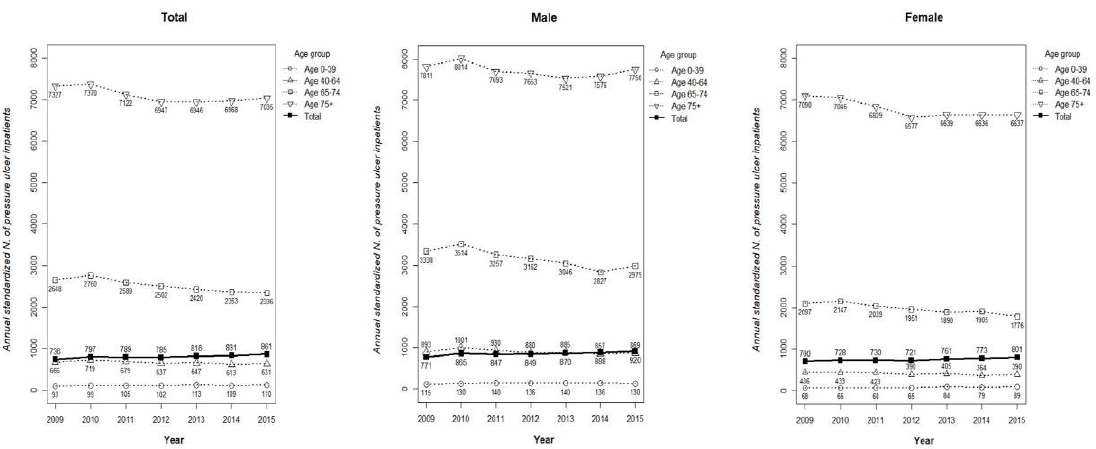
Figure 1. Standardized number of PI inpatients per 10 5 populations by age and sex using the population data from the Statistics Korea.